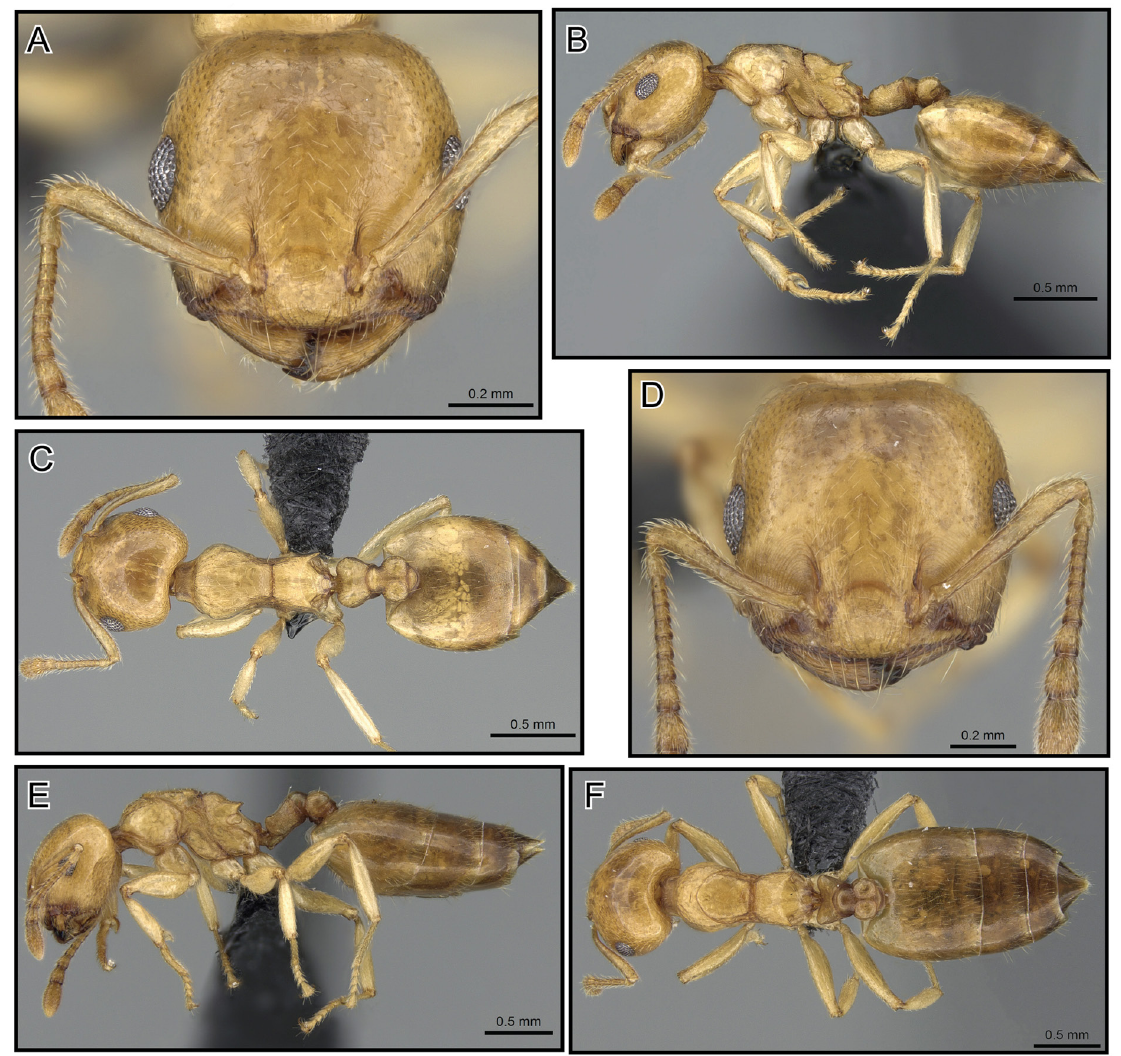
Fig. 15. Crematogaster maina sp. nov., workers. A-C. Worker (CASENT0317758). A. Full-face. B. Profile. C. Dorsal. D-F. Worker (CASENT0317760). D. Full-face. E. Profile. F.